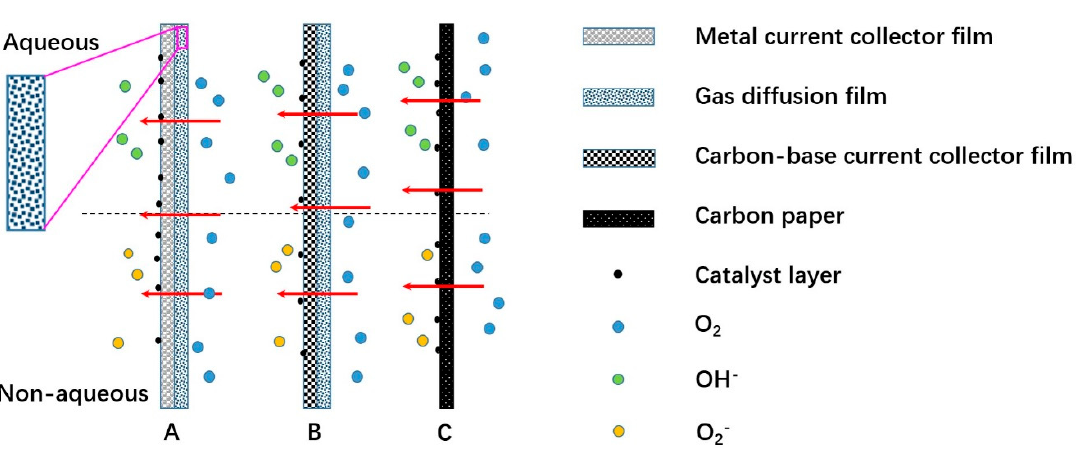
Figure 5. Various cathodic electrode of MABs, ( A ) metal current collector with a gas diffusion layer and coated catalyst facing electrolyte, ( B ) carbon-base current collector and gas diffusion and catalyst, ( C ) carbon paper-current collector and gas diffusion and catalyst.